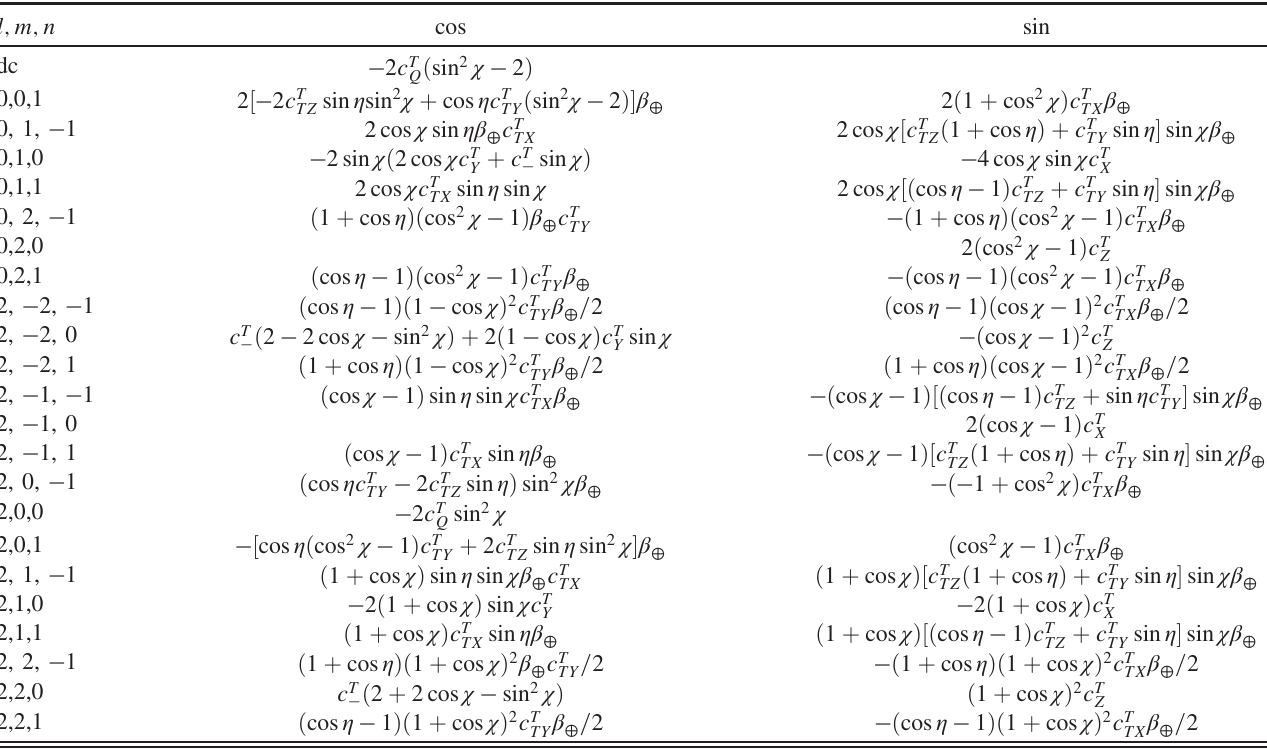
TABLE II. Signal components for one rotating crystal oscillator compared against a stationary reference that is not affected by the c coefficients. Signal components suppressed by β 2 ⊕ and higher powers are omitted. These coefficients are to be inserted in Eq. (9) and are multiplied by 1 = 8 to give the frequency